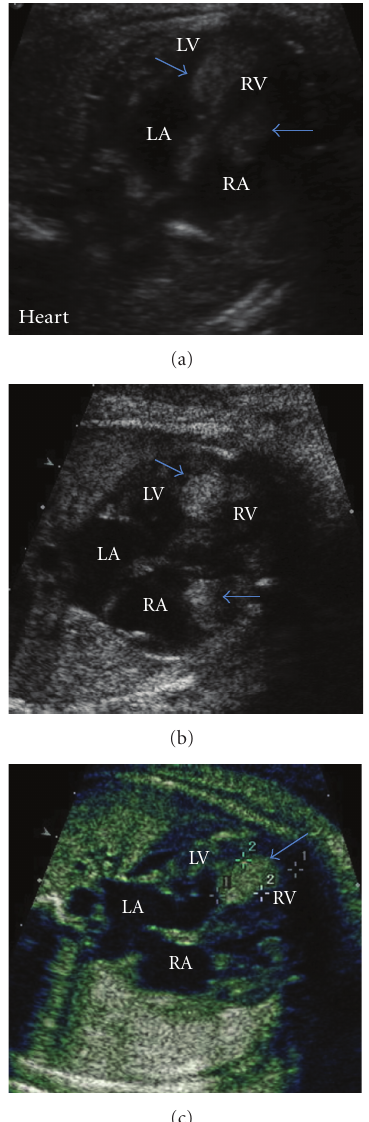
Figure 2: (a) On ultrasound, a single small, echogenic lesion was detected within the parenchyma of the upper pole of the right kidney, consistent with an angiomyolipoma. (b) T-2-weighted MRI image, in the transverse plane, at the level of the top of the right kidney demonstrates a high-signal lesion within the upper pole (arrow). K, kidneys; MS, maternal spine. (c) TruFISP coronal image through the kidneys shows another view of the same lesion (arrow) K, kidney; ML, maternal liver; L,